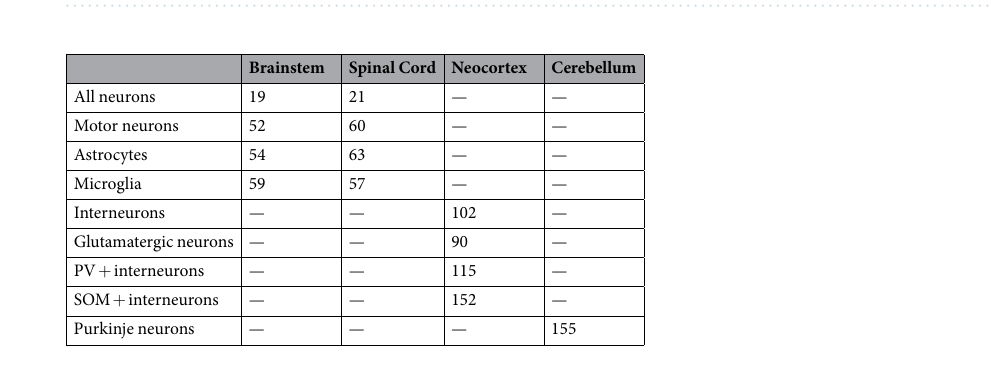
Table 1. Number of detectable miRNAs statistically enriched in each assayed population relative to tissue level